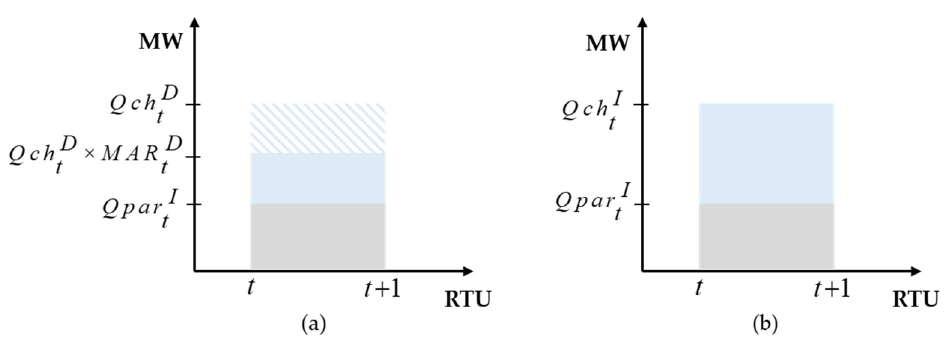
Figure 3. (a) Indivisible parent order and divisible child order; (b ) Indivisible parent order and indivisible child